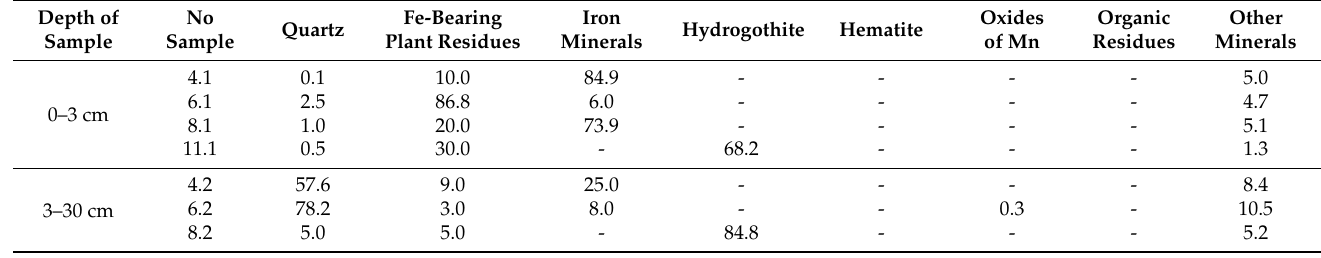
Table 3. Mineralogical composition of soil of Chloridic Gleyic Fluvic Solonchak (Hypersalic, Loamic, Technic) in seepage areas in the Lyonva River Valley (%).